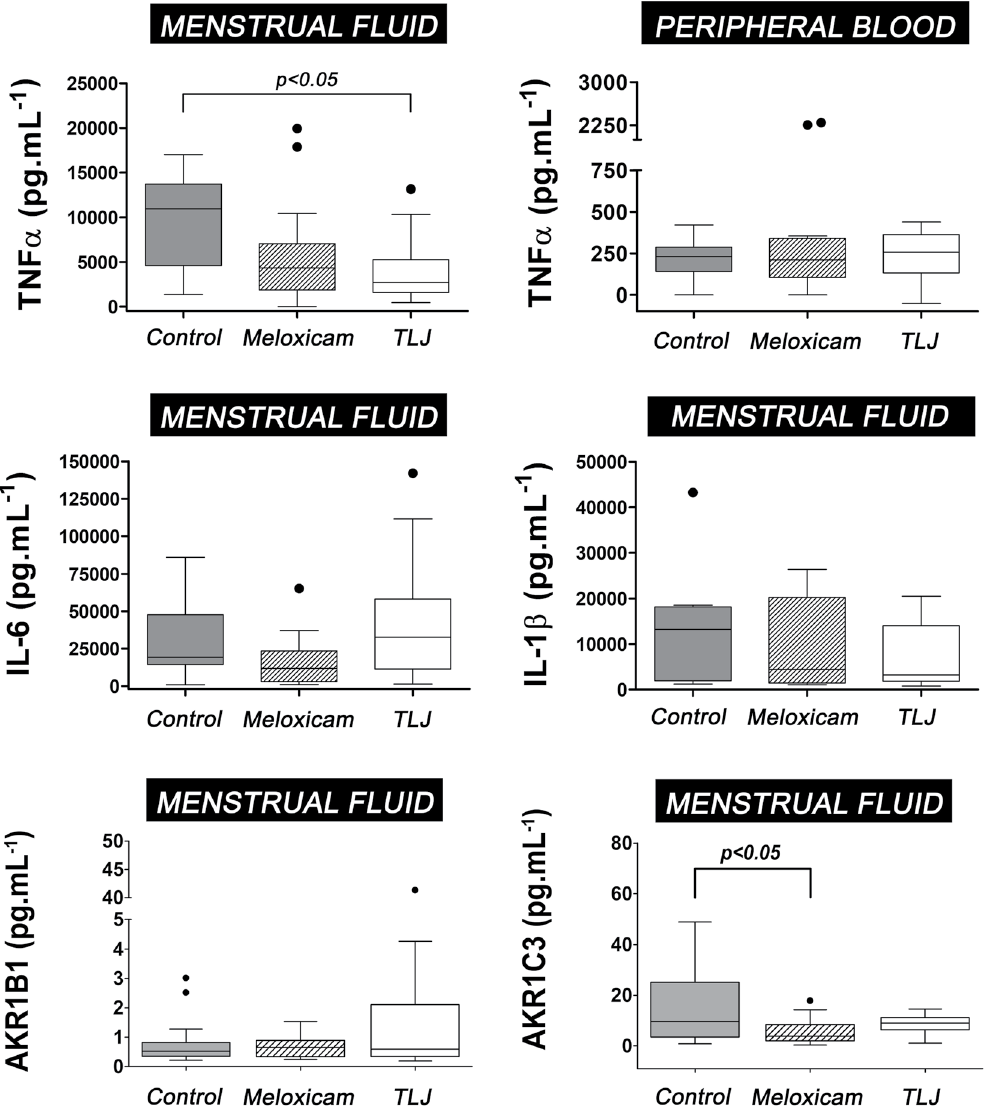
Figure 7. Reduction of the menstrual level of TNF- α from women that consumed TLJ at beginning of the menstruation. Box-plot showing the comparing of the levels of TNF- α , IL-6, IL-1 β and of the enzymes AKR1B1 and AKR1C3 from menstrual fluid or peripheral serum of women submitted or not (n = 14) to TLJ (n = 16) or meloxicam (n = 16). The medians were compared using the Kruskal-Wallis and Dunn´s statistical tests for multiple